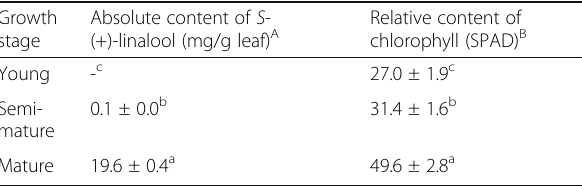
Table 3 Content of S -(+)-linalool and chlorophyll of leaves at three stages of maturity Growth Absolute content of S - stage (+)-linalool (mg/g leaf)